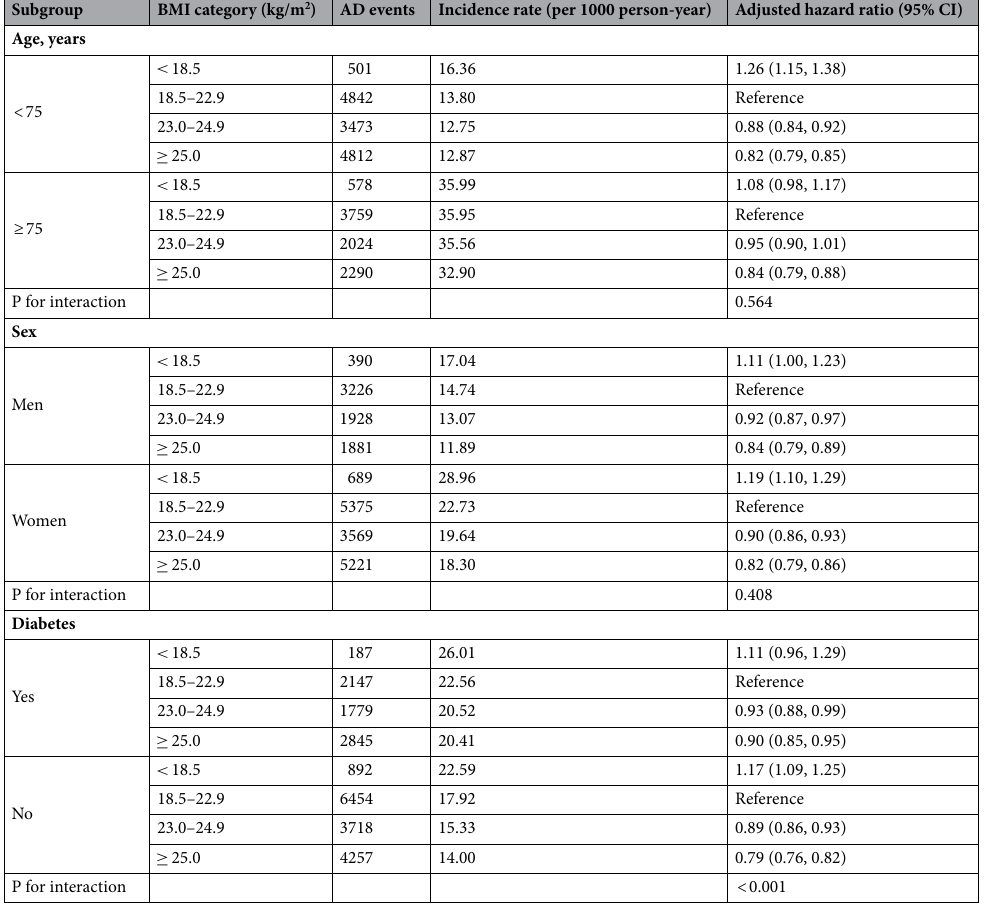
Table 3. Subgroup analysis of adjusted hazard ratio for AD by BMI according to age, sex, and diabetes. BMI, body mass index; AD, Alzheimer’s dementia. a Adjusted for age and sex. b Adjusted for variables in model 1 and smoking, alcohol consumption, regular exercise, and low-income status. c Adjusted for variables in model 2 and hypertension, diabetes mellitus, dyslipidemia, and cardiovascular